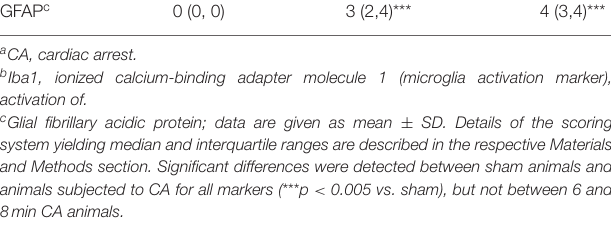
Frontiers in Medicine |